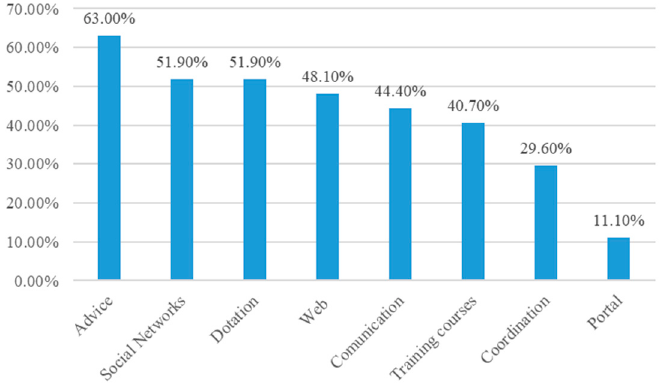
Figure 6. Functions performed by CICTs in HCMs and ACSs.